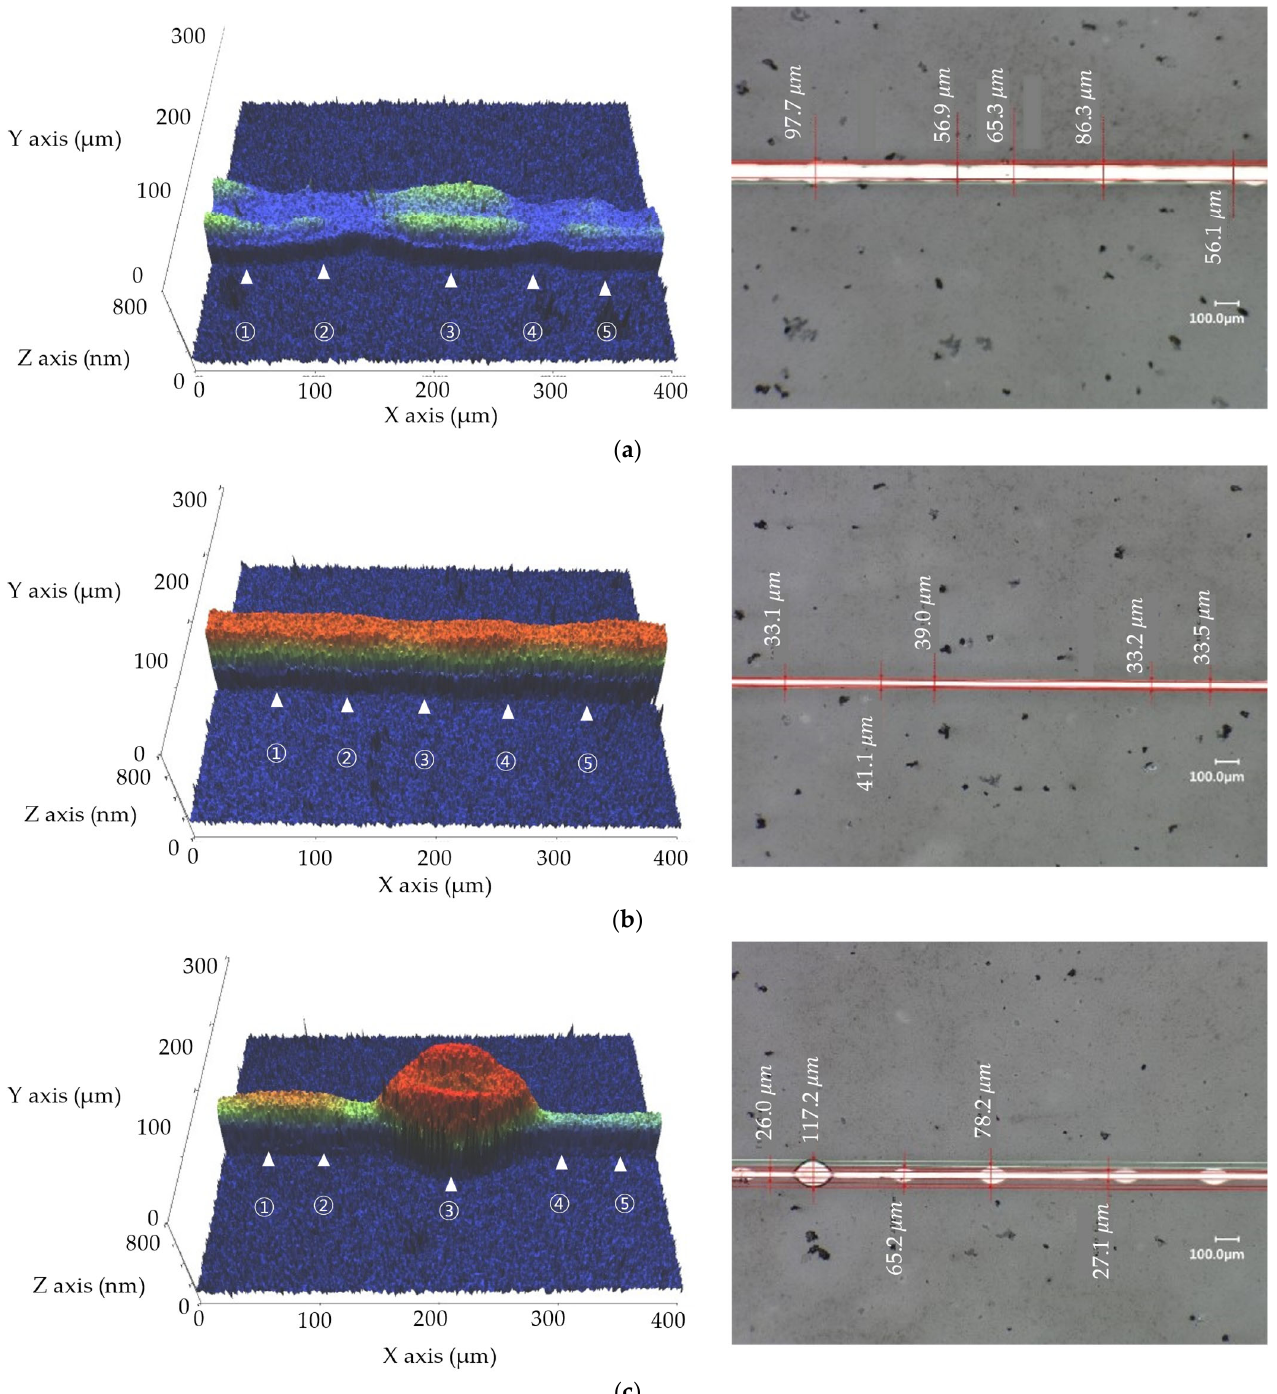
Figure 5. The 3D and 2D profiles of printed silver lines with inkjet drop spacing of 10 µ m and various laser ablation widths: ( a ) 80 µm, ( b ) 40 µm, and ( c ) 20 µm.